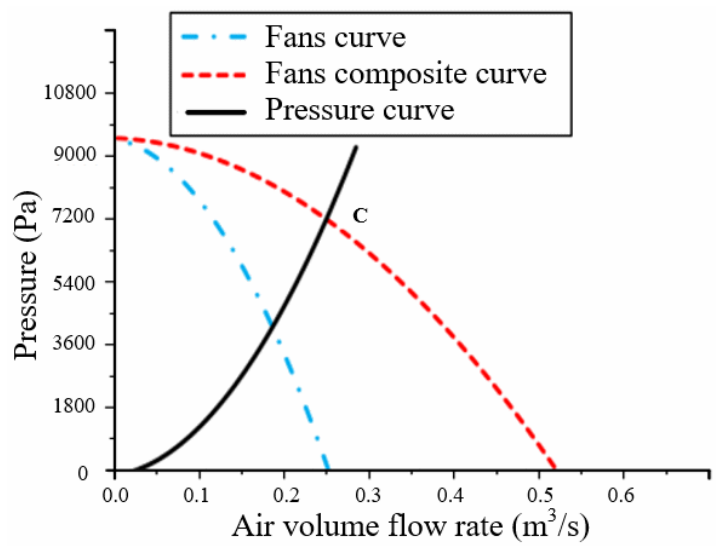
Figure 8. Parallel fans behavior of the FACAVS HSPMSM.